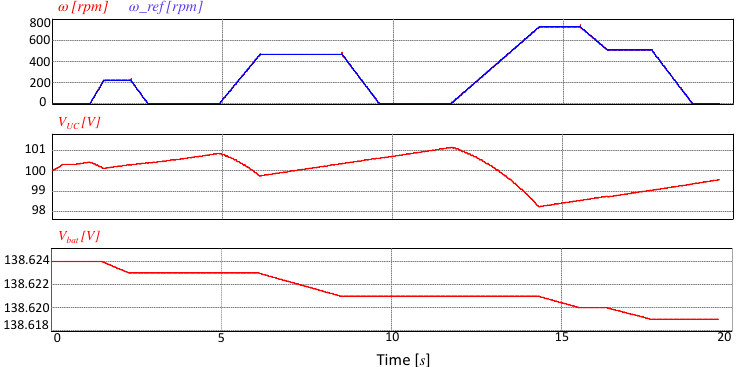
Figure 18. Behavior of the energy storage devices through the ECE-15 cycle. The speed of the motor following the ECE-15 cycle; the voltage in the ultracapacitor V UC and the voltage in the battery V bat .